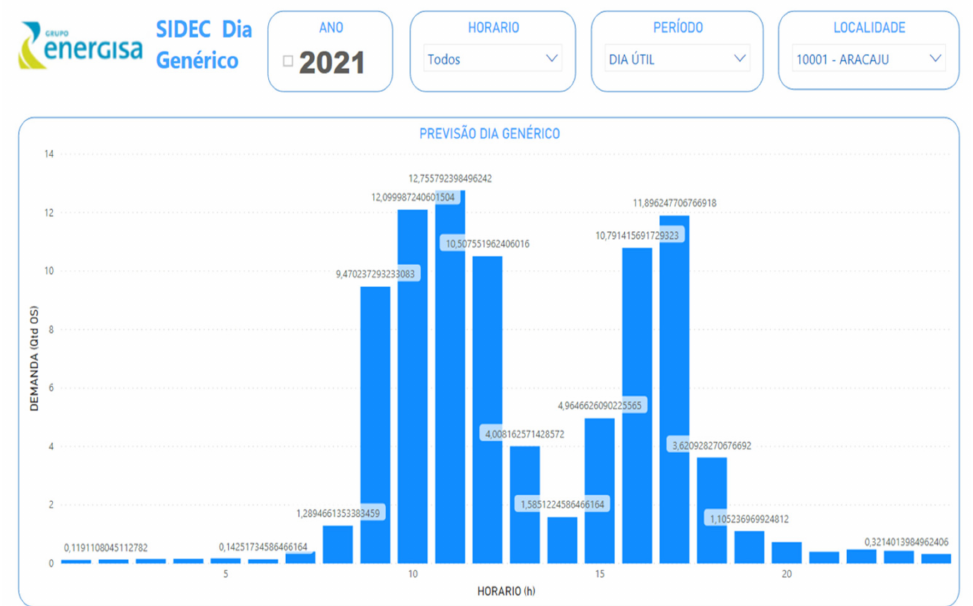
Figure 7. Hourly distribution of service order demand forecasted for a day. This figure is one of the graphical interfaces of AWDEC, developed in Microsoft Power BI. The terms in Portuguese represents year (ano), hour (hor á rio), week period (per í odo), location (localidade) and demand (demanda). The horizontal axis (horario) represents the 24 h of a given